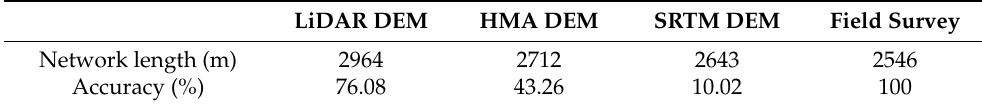
Table 1. Summary of stream networks derived from different sources.